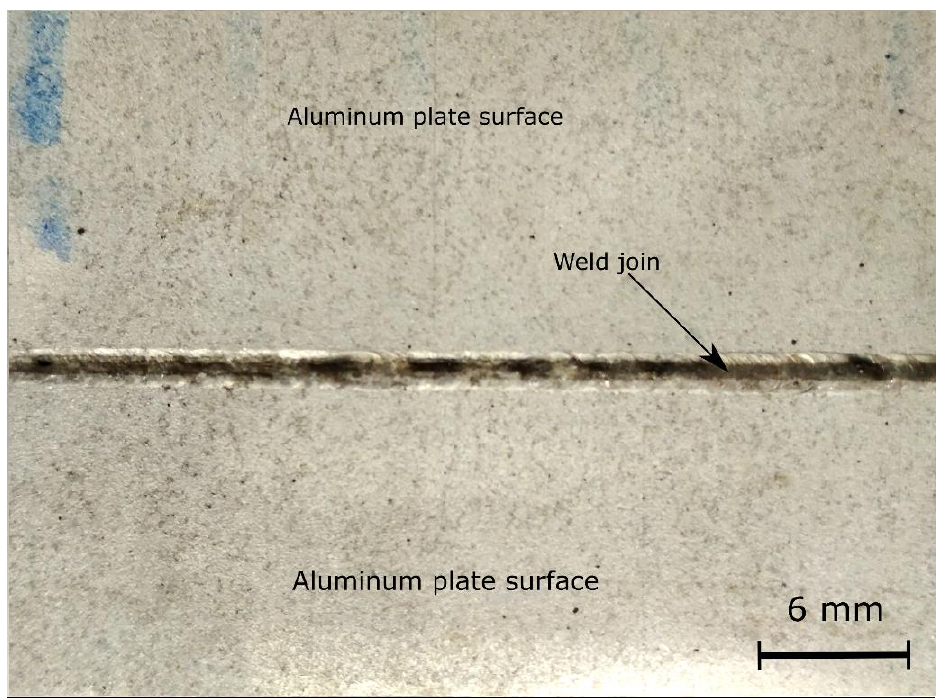
Figure 1. The image of the typical front surface of two aluminum plates of the initial 1550 alloy with the weld.